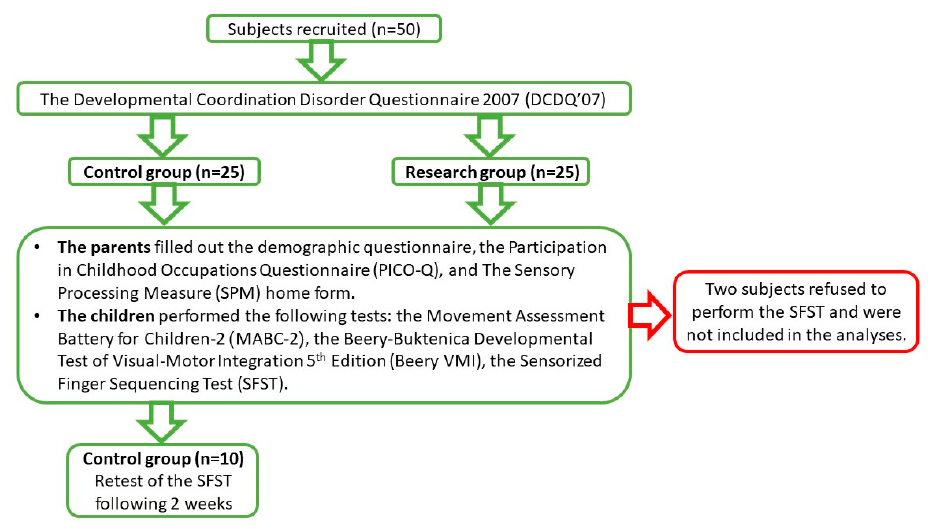
Figure 2. The study outline.